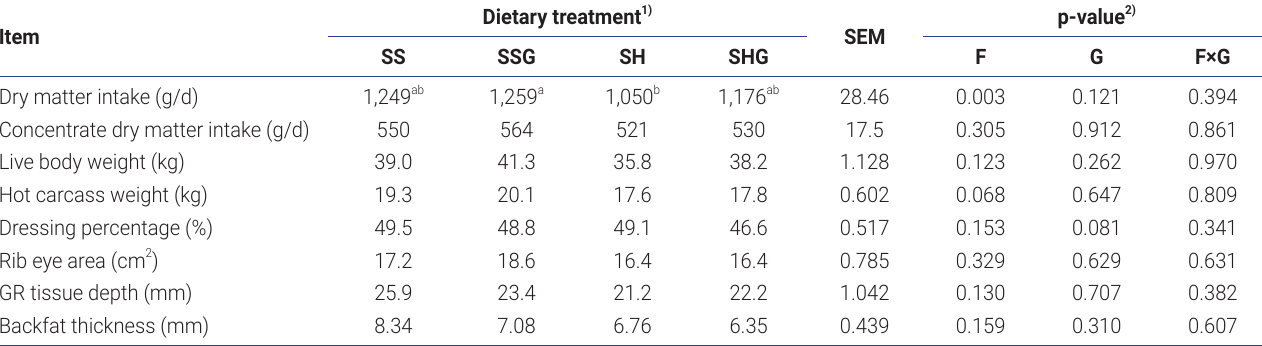
Table 3. Effect of grapeseeds (G) and sweet sorghum forage (F) on dry matter intake and carcass parameters in Small-tailed Han lambs